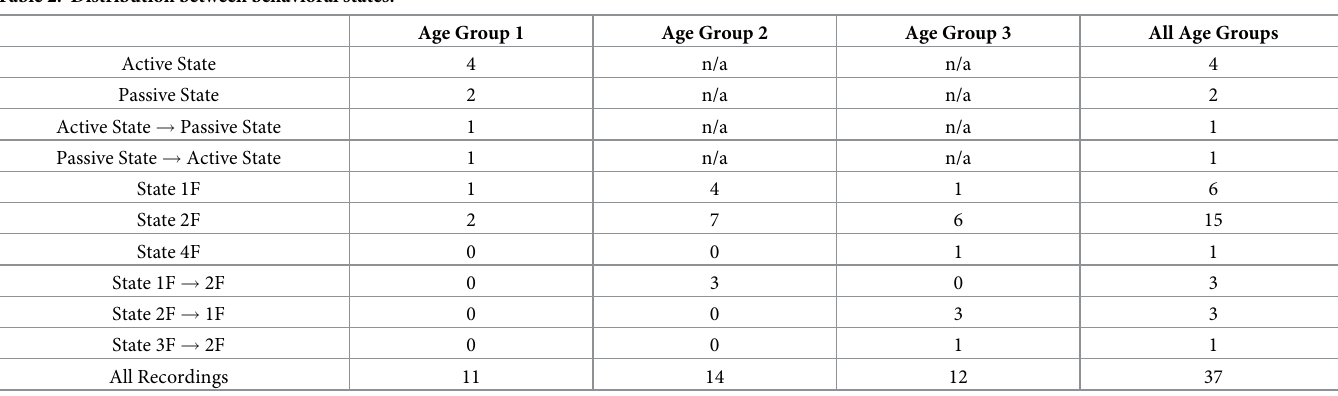
Table 2. Distribution between behavioral states.